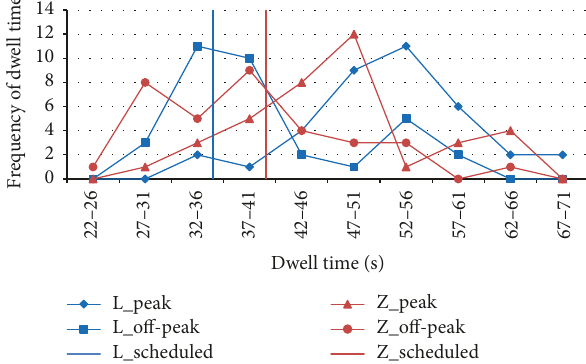
Figure 2: Distribution of the actual and scheduled dwell times in the Dutch railway stations. Figure 3: Distribution of the actual and scheduled dwell times in the Beijing urban railway